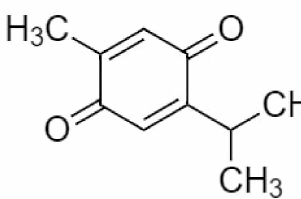
Figure 1. Chemical structure of